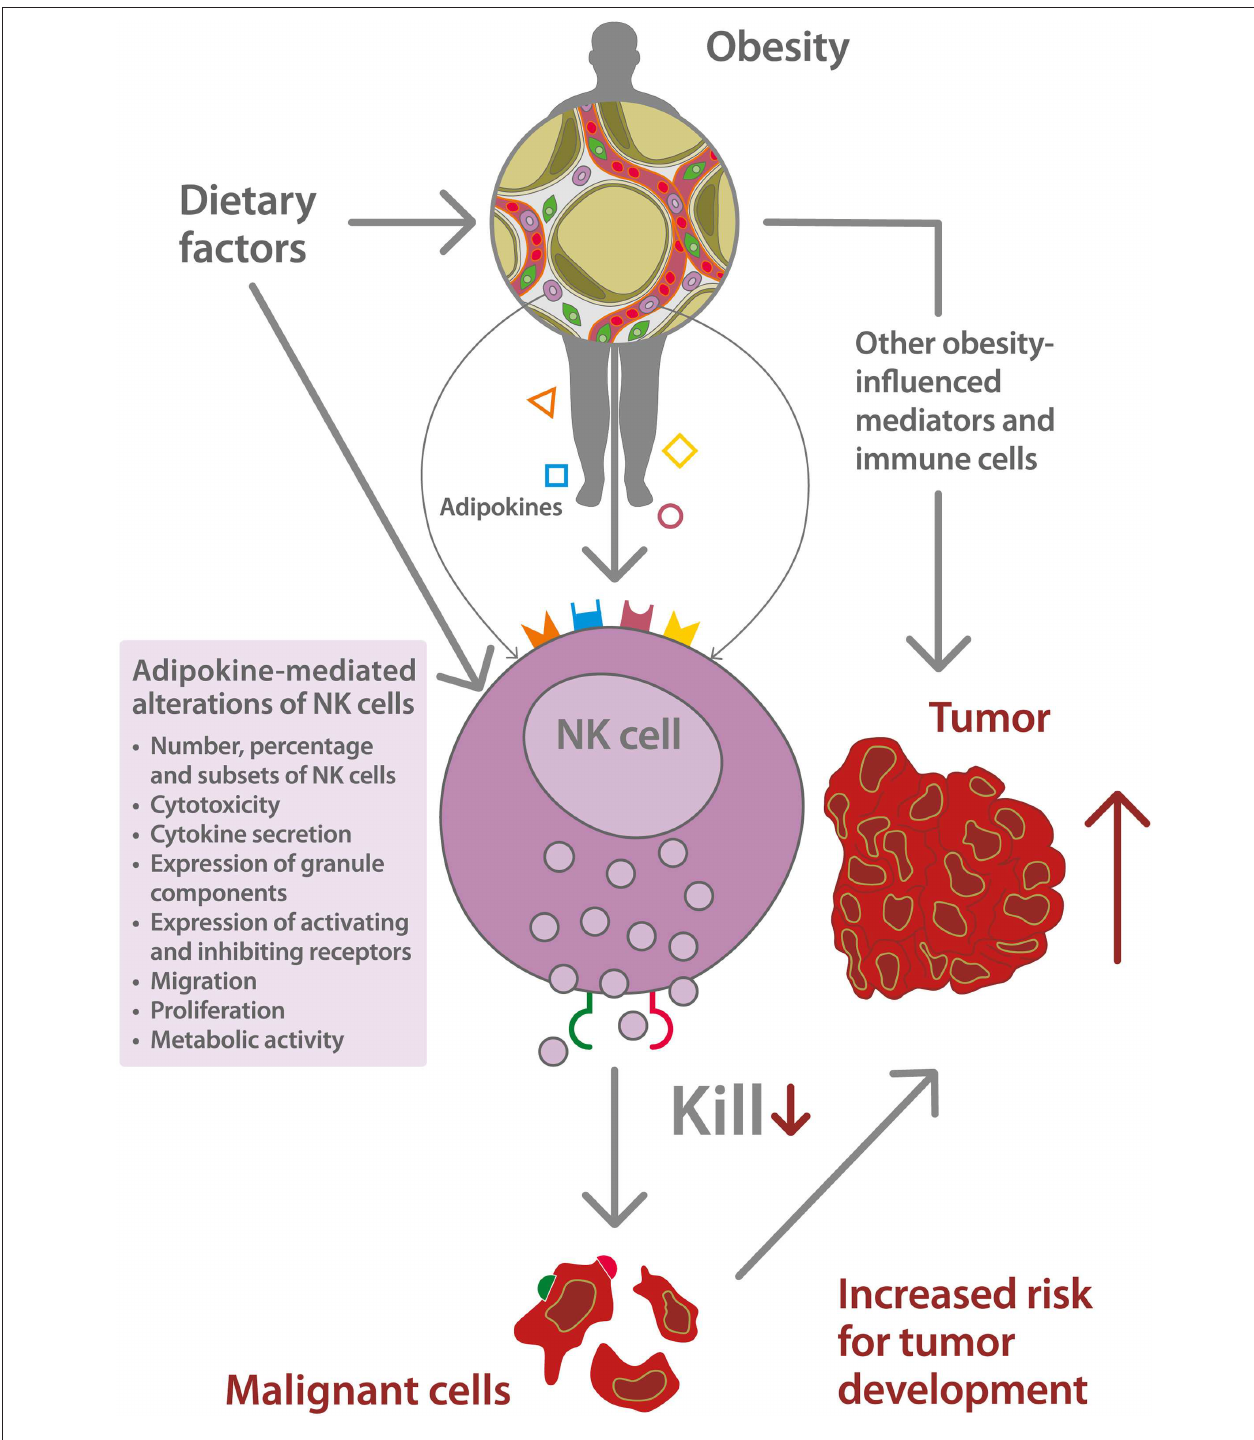
FIGURE 1 | Schematic depiction of the impact of natural killer (NK) cell dysfunction on the increased risk for tumor development in obesity. Dietary factors, like high energy intake or high intake of saturated fatty acids, promote the development of overweight and obesity and mediate direct effects on NK cell function. Obesity is associated with an excessive growth of adipose tissue and a dysregulated secretion of adipokines, like leptin ( △ ), adiponectin ( (cid:3) ), interleukin-6 ( (cid:13) ), estrogens ( ♦ ), and others. The obesity-related metabolic environment leads to an altered NK cell functionality including a dysbalance of the expression of activating and inhibiting NK cell receptors as well as NK cell receptor ligands ( w , w ) on tumor cells. This NK cell dysfunction is associated with a decreased killing capacity of malignant cells and an increased risk for tumor development.